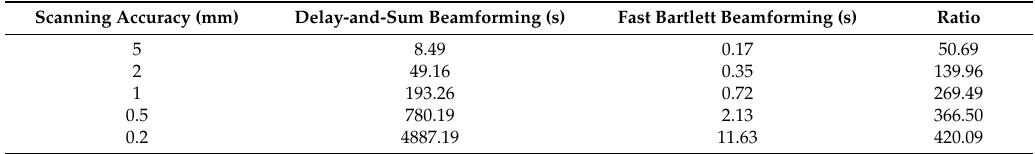
Table 4. Localization results comparison by PLB test.